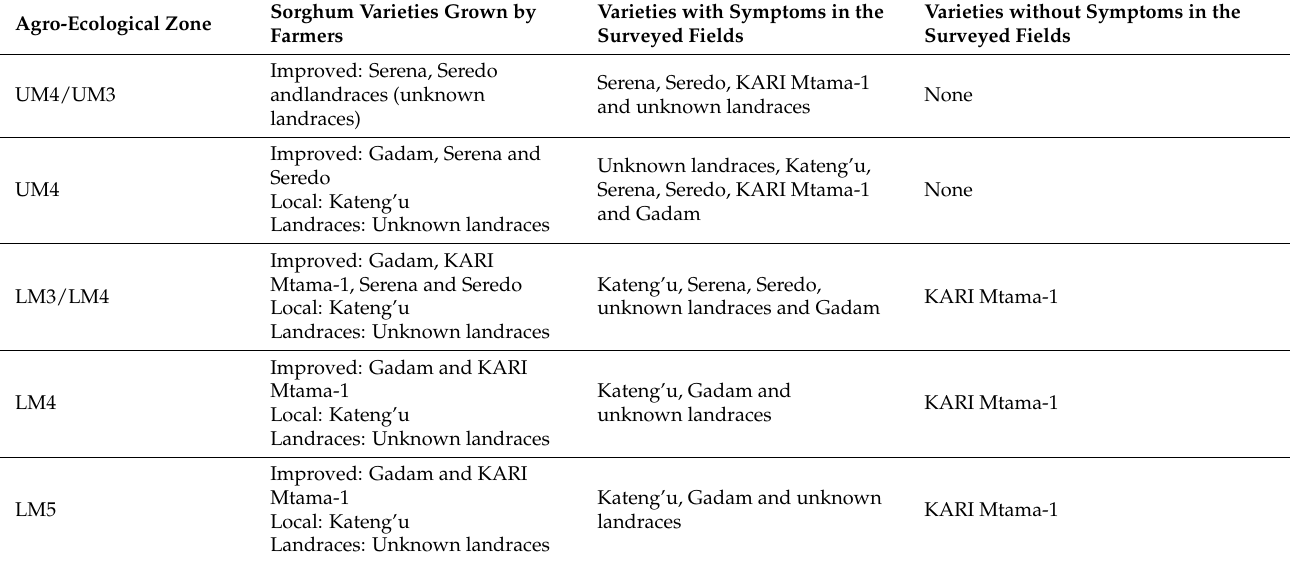
Varieties without Symptoms in the Surveyed Fields